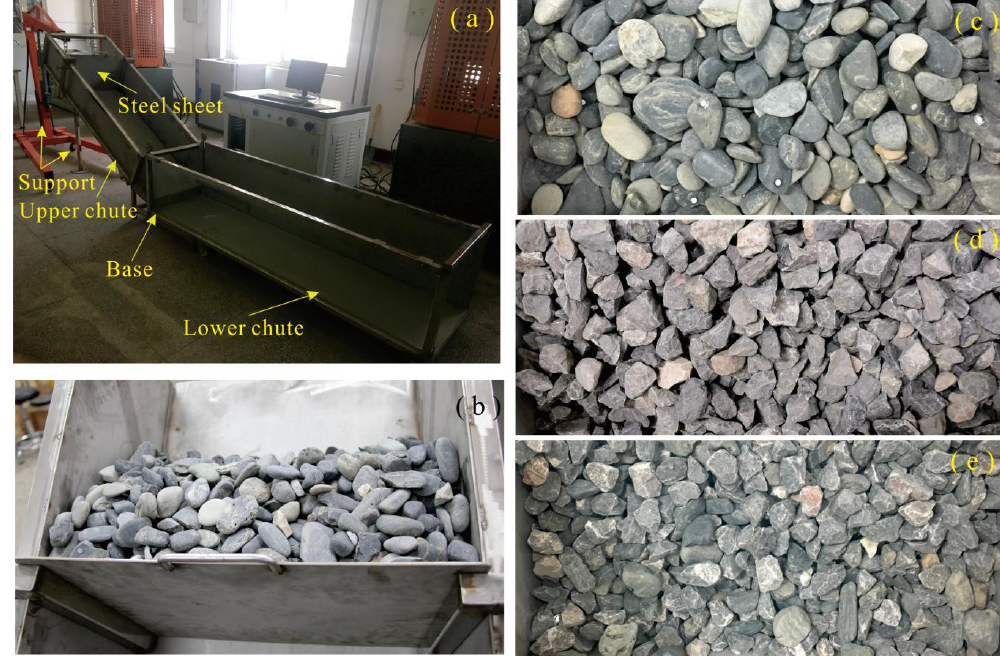
Figure 1. The experiment equipment and sliding materials used in physical model: ( a ) flume, ( b ) steel sheet, ( c ) pebbles, ( d ) gravels, and ( e ) mixtures.